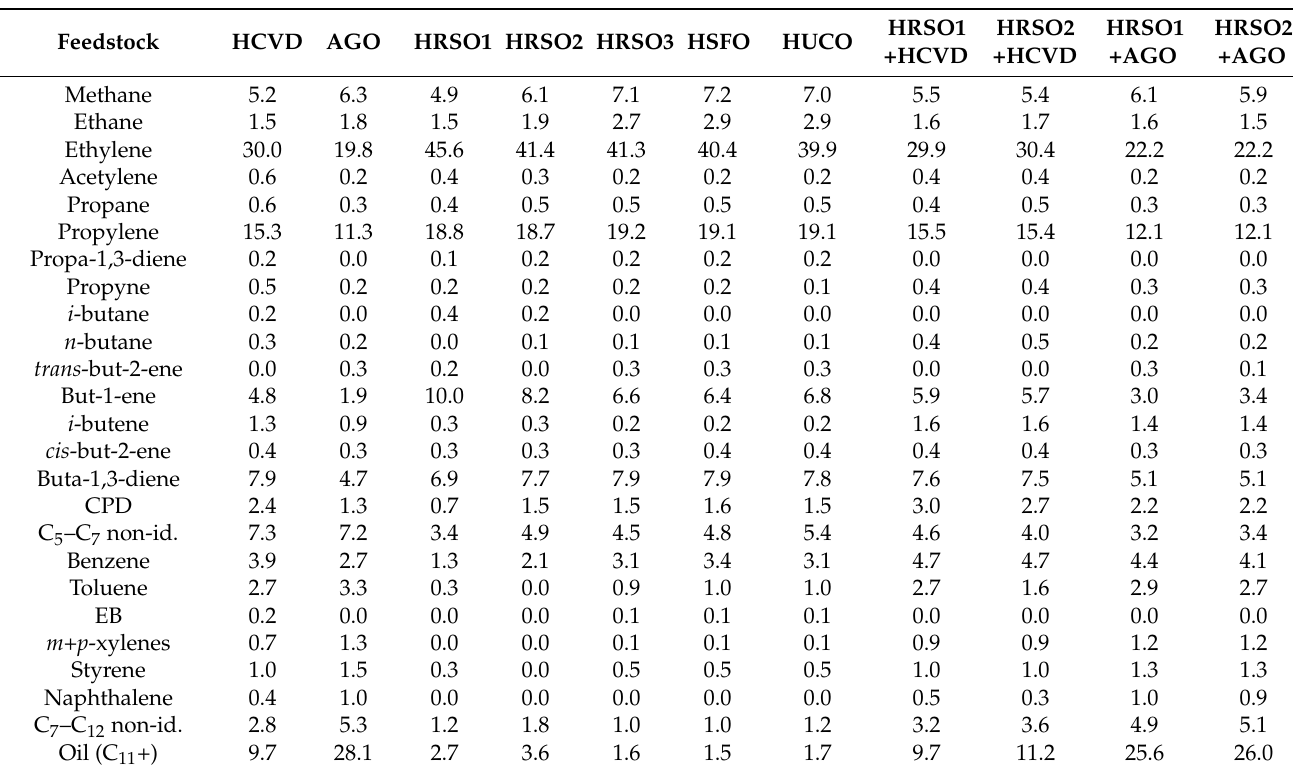
Table 4. Products distribution (in wt.%) obtained at 800 ◦ C, under 400 kPa and 65 NmL/min for pure traditional feedstocks (HCVD and AGO), pure HVOs (HRSO1, HRSO2, HRSO3, HSFO and HUCO) and blends containing 10 wt.% of HRSO1 or HRSO2 in HCVD or